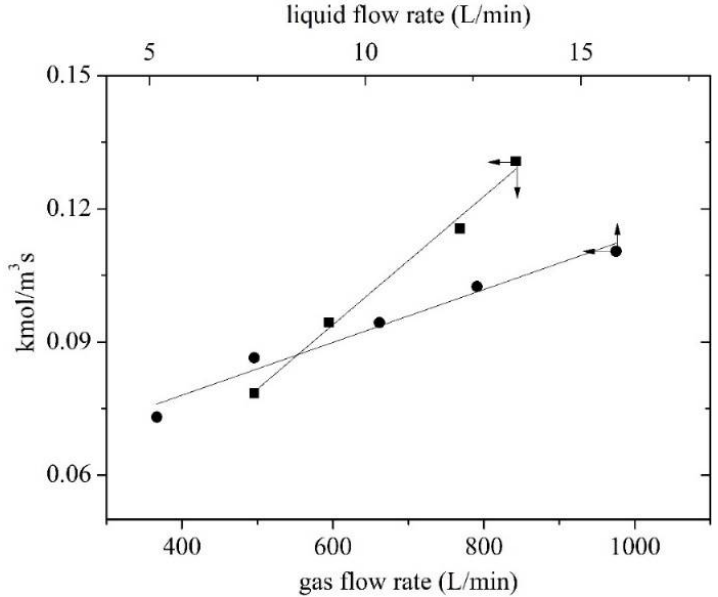
Figure 5. Effects of gas and liquid flow rates on mass transfer coefficient. ( • : liquid flow rate; (cid:4) : gas flow rate).